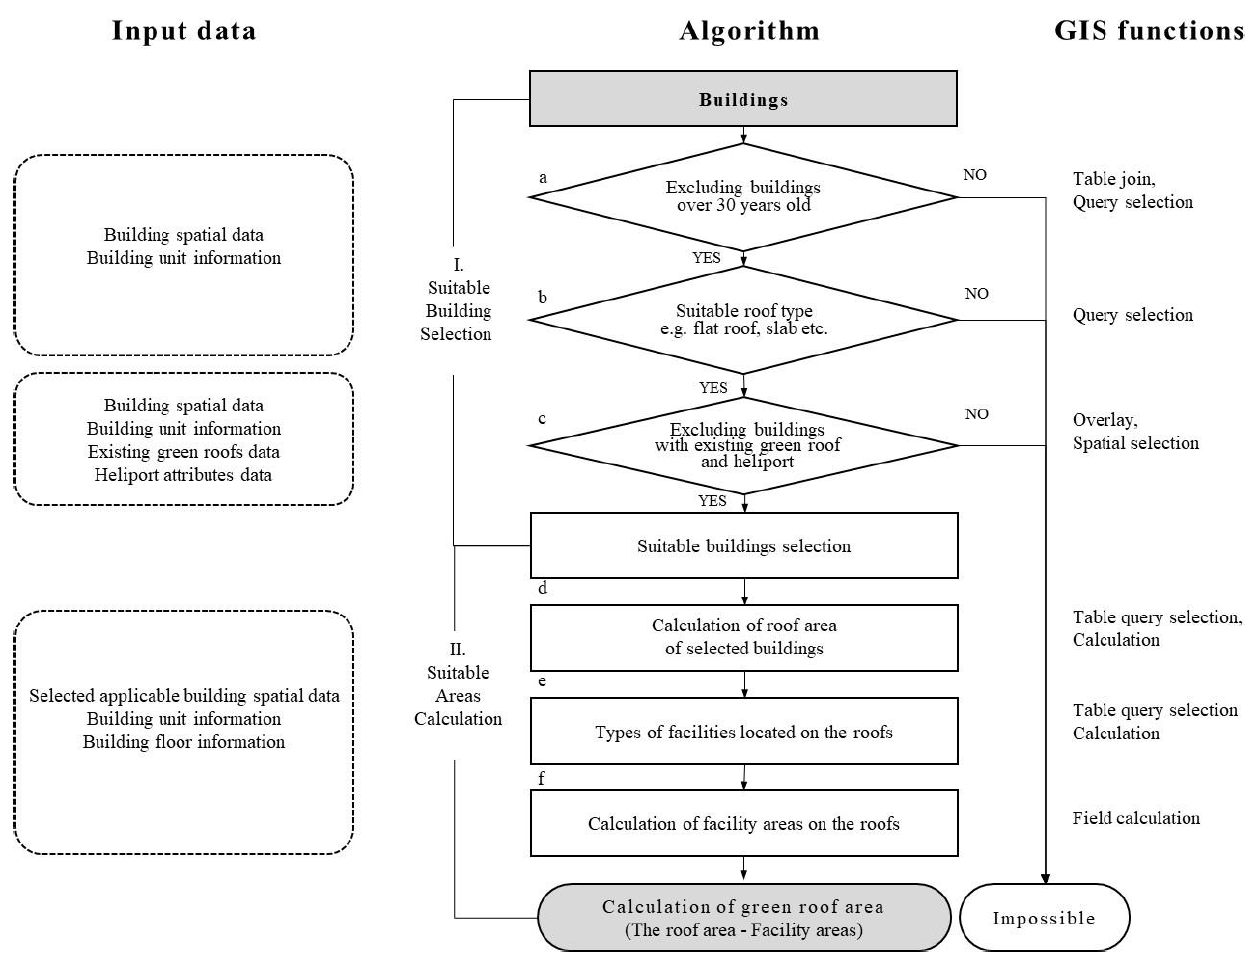
Figure 2. Algorithm for analyzing suitable locations for green roofs.